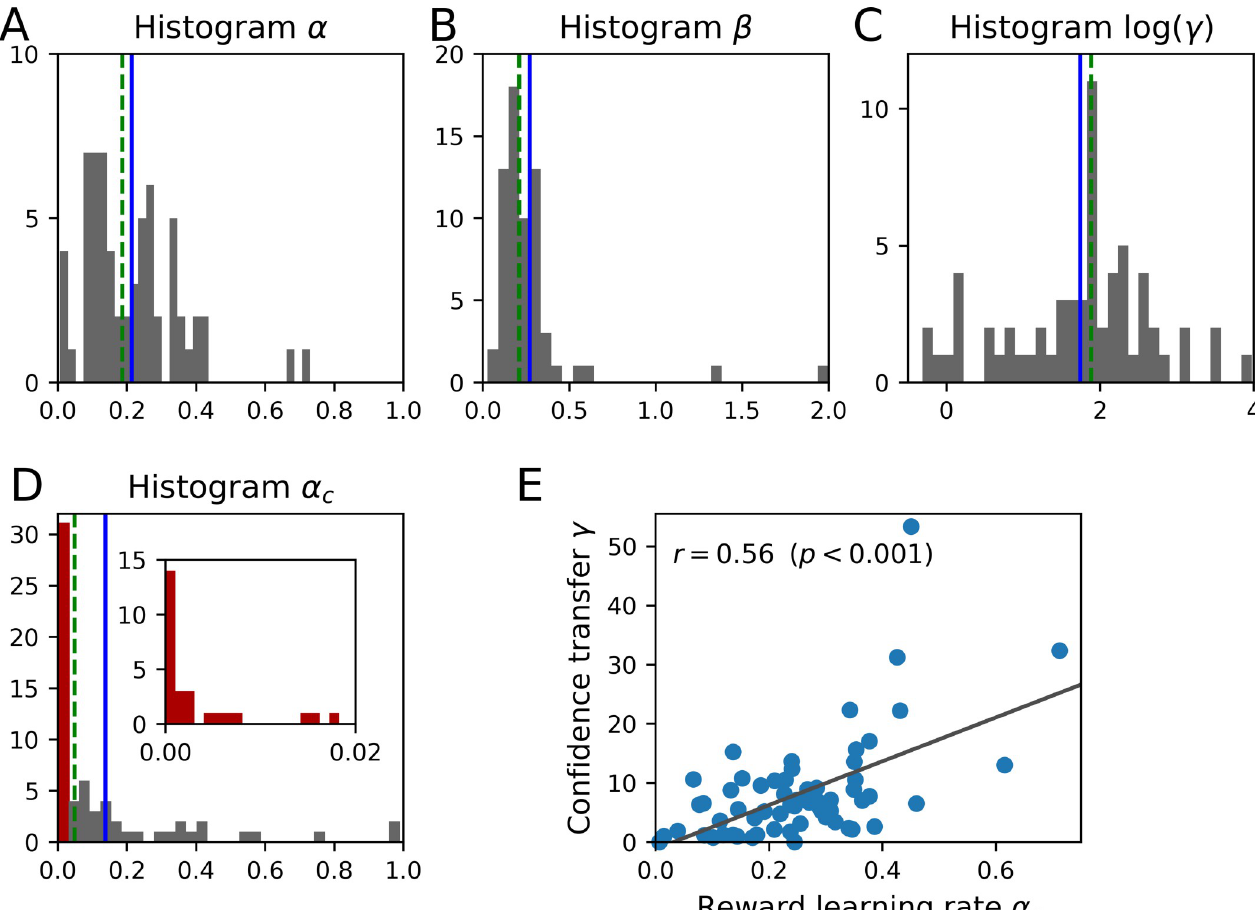
Fig 6. Model parameters for the winning model ConfUnspec . Blue solid lines indicate parameter means, green dashed lines parameter medians. (A) Histogram of the reward learning rate α . (B) Histogram of the inverse decision noise parameter β . (C) Histogram of the confidence transfer parameter γ . (D) r Histogram of confidence learning rate α c . (E) Scatter plot between reward learning rate α r and confidence transfer γ . The black line indicates a linear fit to the data; the correlation coefficient is based on a Pearson correlation.